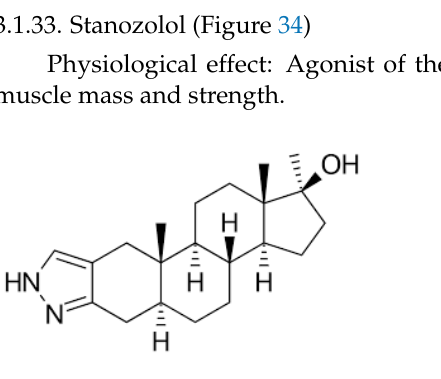
Figure 34. Chemical structure of stanozolol. Formula: C 21 H 32 N 2 O.